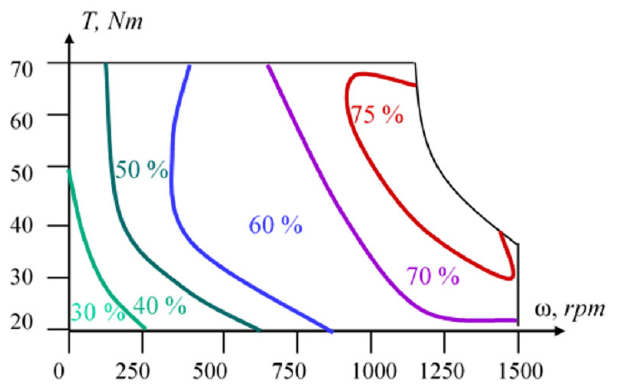
Figure 8. Efficiency map of an EM in torque ( T ) to speed ( ω ) reference frame.